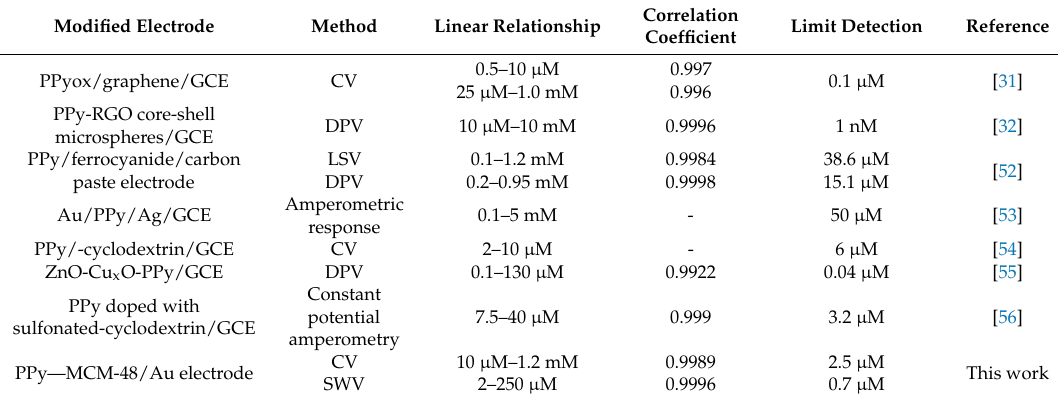
Table 1. The comparison of the results for the determination of dopamine using different polypyrrole composite-modified